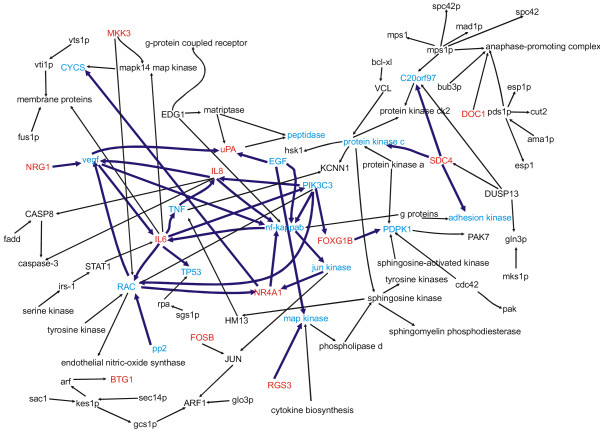
S1P-Network. Interaction network for differentially expressed genes (sentences related to S1P). The directed pseudograph of relationships related to S1P was generated as described in materials and methods. Seed vertices (shown in red) are the gene names from the list of 72 differentially expressed genes. Blue vertices and bold purple arcs represent genes and relationships that were found in this interaction network and in the interaction network related to invasivity shown in Figure 4.